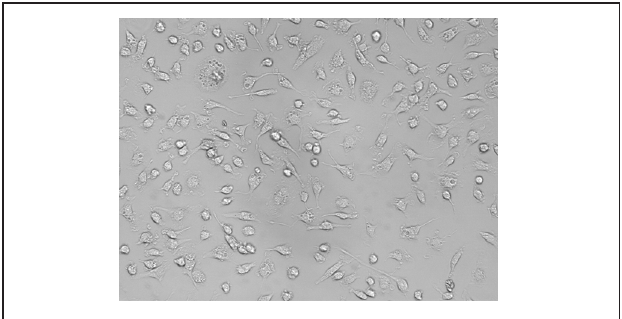
FIGURE 2 | Findings at 28 days after GDNF + MSCs transplantation.